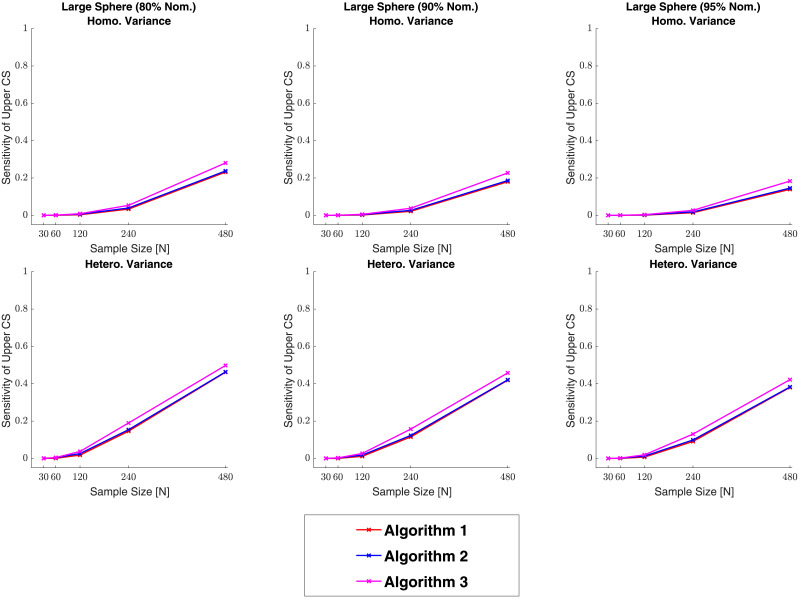
Sensitivity results for the large sphere signal, with homogeneous (top row) and heterogeneous (bottom row) Gaussian noise structures.